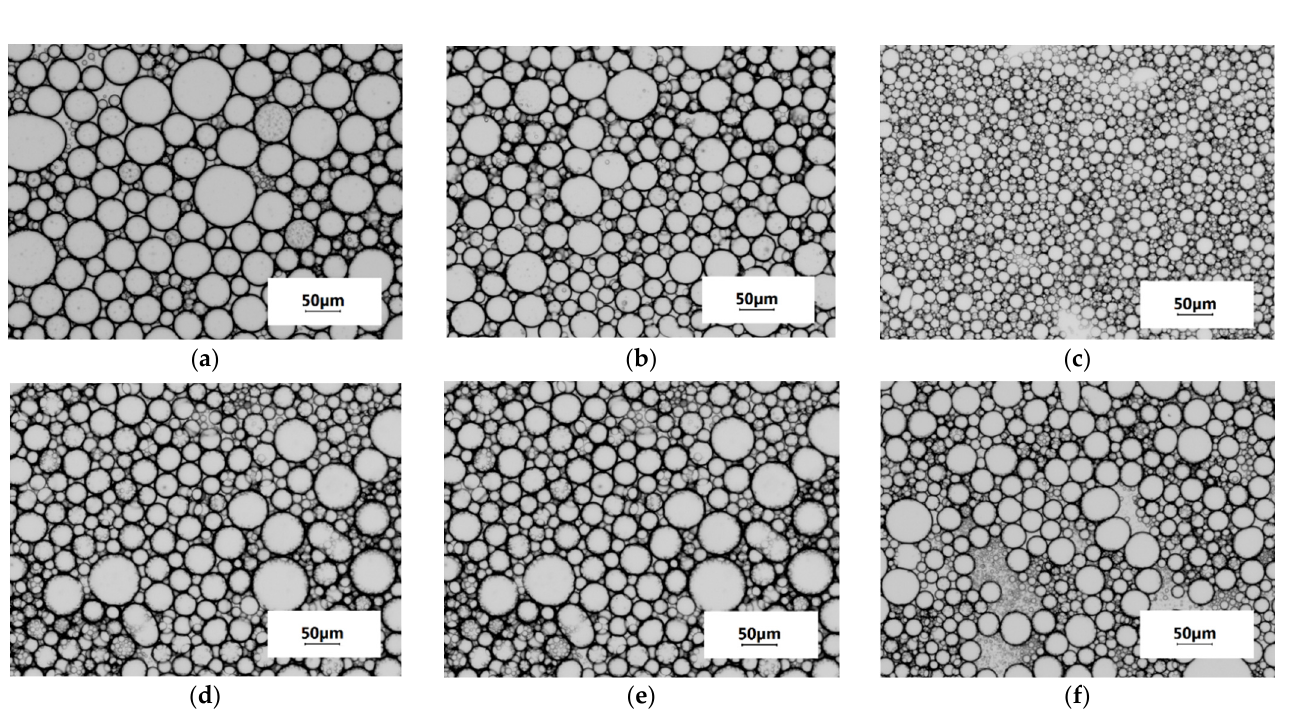
Figure 5. Microphotographs of concentrated emulsions stabilized with FPI 4-16 ( a – c ) and FPI 20-4 ( d – f ). C(FPI), % ( w / v ): 1.0 ( a , d ); 2.0 ( b , e ); and 5.0 ( c , f ). Magnification 10×.